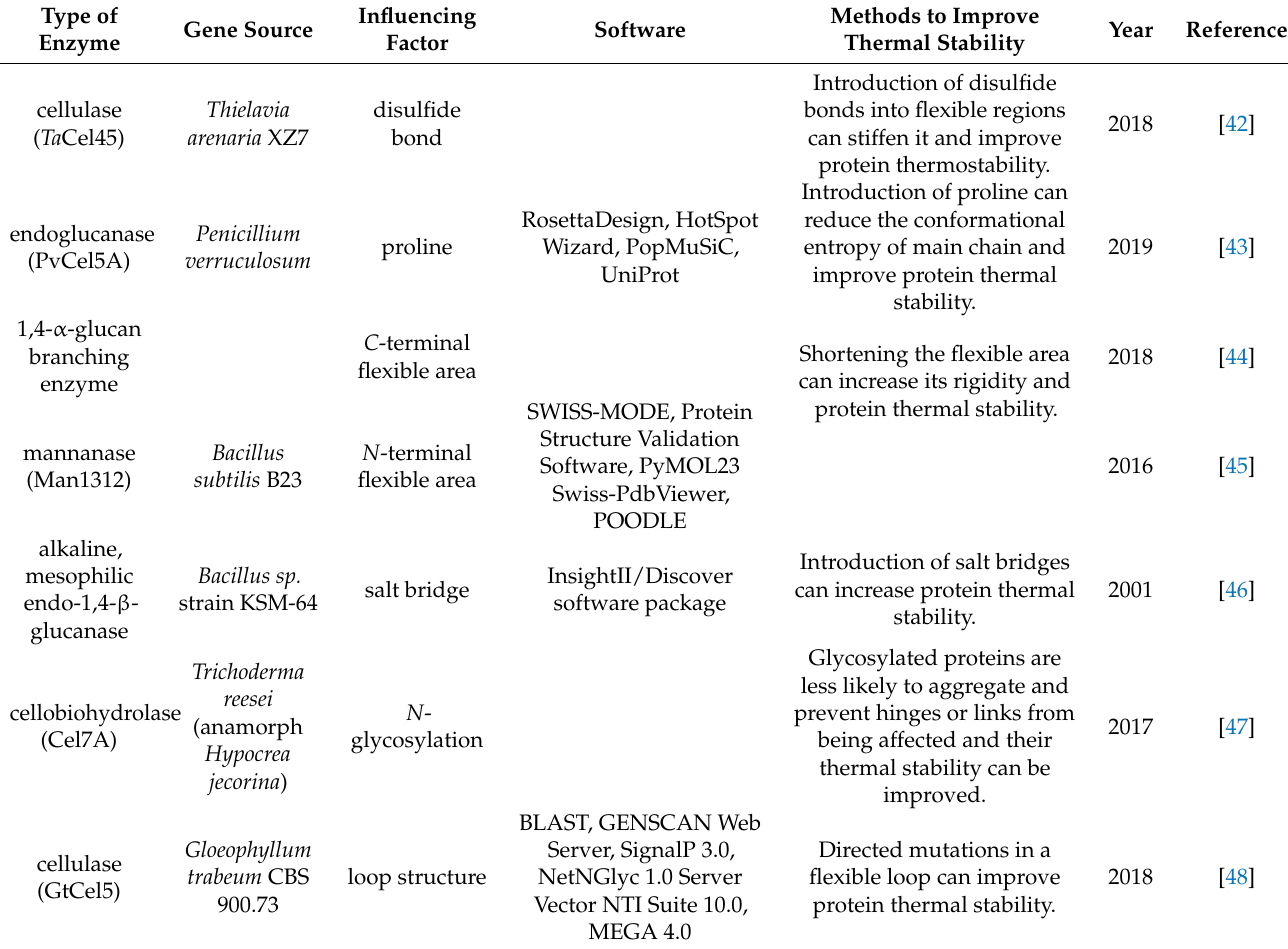
Table 3. Methods for stiffening flexible